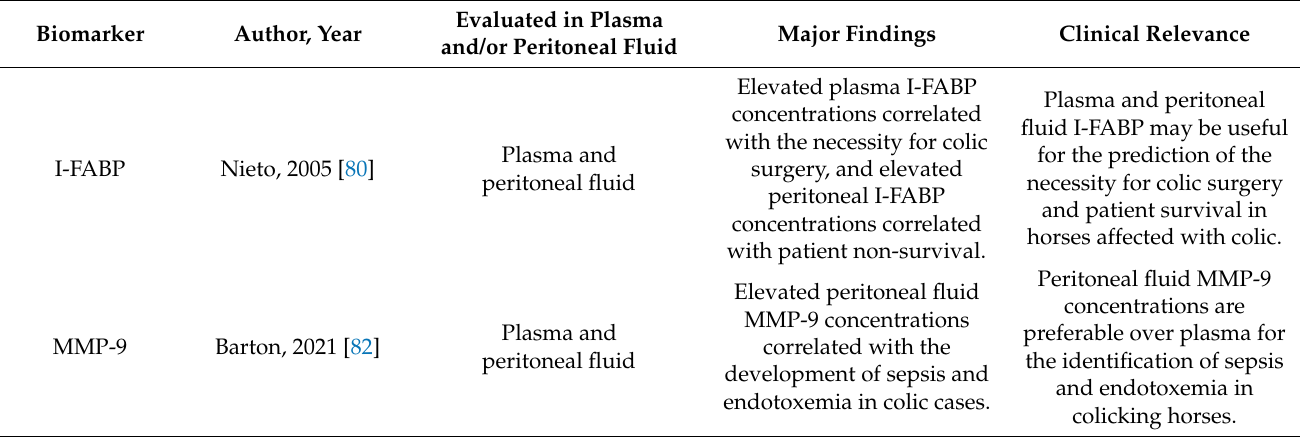
Table 1. Biomarkers with single-mention use in equine